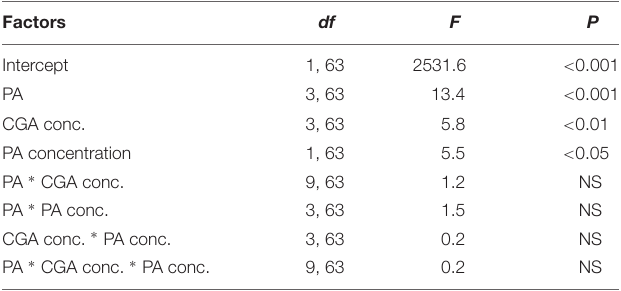
TABLE 2 | Three-way ANOVA with PA free base, CGA concentration and PA concentration as factors and the interaction effect S X ∗ Y as a dependent